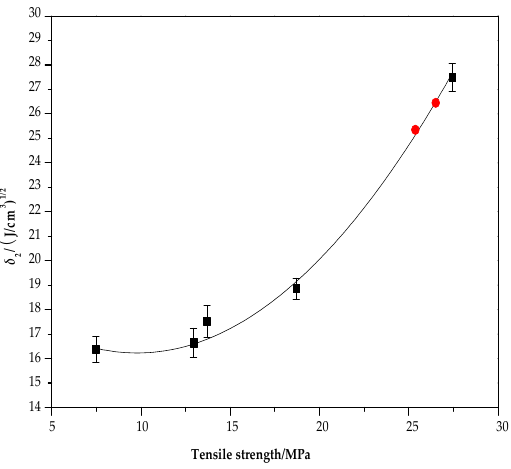
Figure 5. Tensile strength vs solubility parameter ( δ 2 ) of alkali lignin/PVA composite membranes. To verify the reliability of the model, lignin/PVA composite membranes with alkali lignin proportions of 3% and 5% were measured by the same method. The solubility parameters of composite membranes with alkali lignin contents of 3% and 5% were 26.29 and 25.16 J/cm 3 , respectively, and the values of tensile strength were 26.40 and 25.30 MPa, respectively (Figure 5). The solubility parameters, calculated using the binomial relationship, were 26.36 and 25.09 J/cm 3 , indicating that the theoretical value obtained from the binomial was consistent with the actual measured value. The tensile strength of lignin/PVA composite membranes increased as the solubility parameter increased.